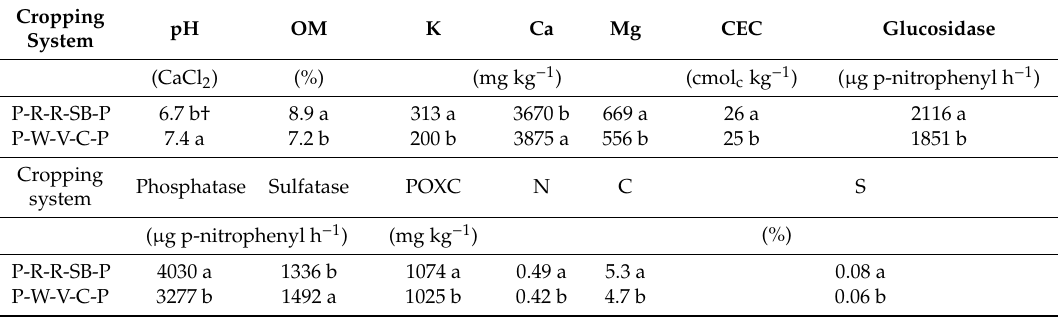
Table 4. pH, OM, K, Ca, Mg, CEC, glucosidase, phosphatase, sulfatase, POXC, N, C, and S as a function of cropping systems in the Minnesota site.